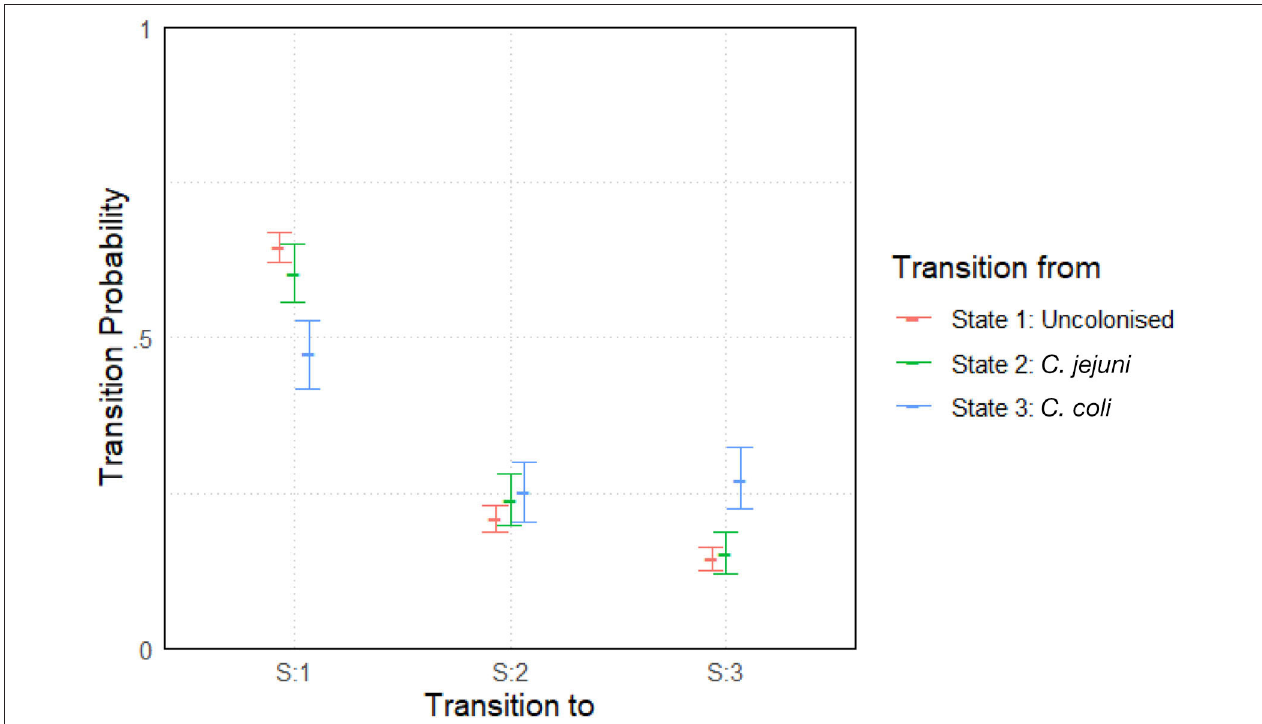
FIGURE 5 | Transition probabilities between three states, “uncolonized,” “colonized by C. jejuni ,” and “colonized by C. coli .” Plots show the median values of the posterior distributions and the 95% highest density intervals